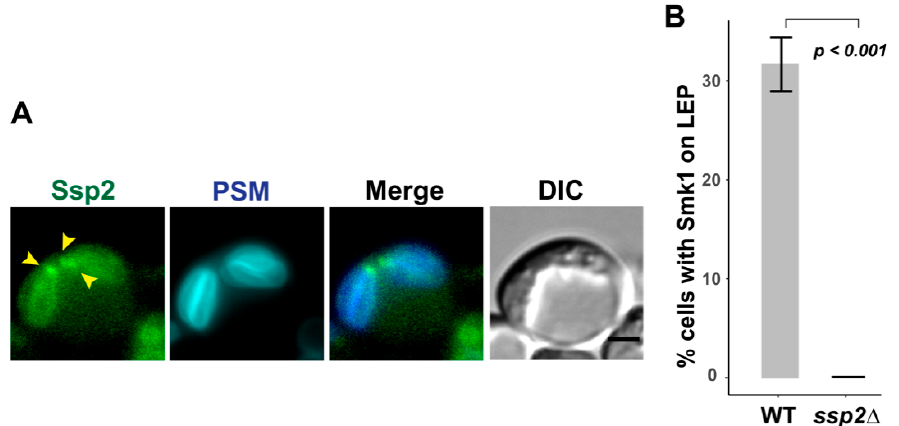
Figure 2. SSP2 is required for Smk1 localization at the leading edge of the prospore membrane. ( A ) Ssp2 localizes to the leading edge of the prospore membrane. Ssp2-GFP Envy is found at the leading edge of the elongated prospore membrane (LH1118). Prospore membranes (PSMs) are labeled with pRS426-Spo20 51–91 -mTagBFP. Yellow arrowheads indicate leading edge localization at the open ends of the tubular elongated prospore membranes. Scale bar = 2 µM. ( B ) Percentage of cells in late meiosis II that have Smk1 localized at the leading edge of the prospore membrane. Wild type (WT; LH1117), ssp2 ∆ (LH1134). Three biological replicates, 100 cells per replicate, were counted for each genotype. Error bars show standard error of the mean. p- value was calculated using Fisher’s exact test (two-tailed).